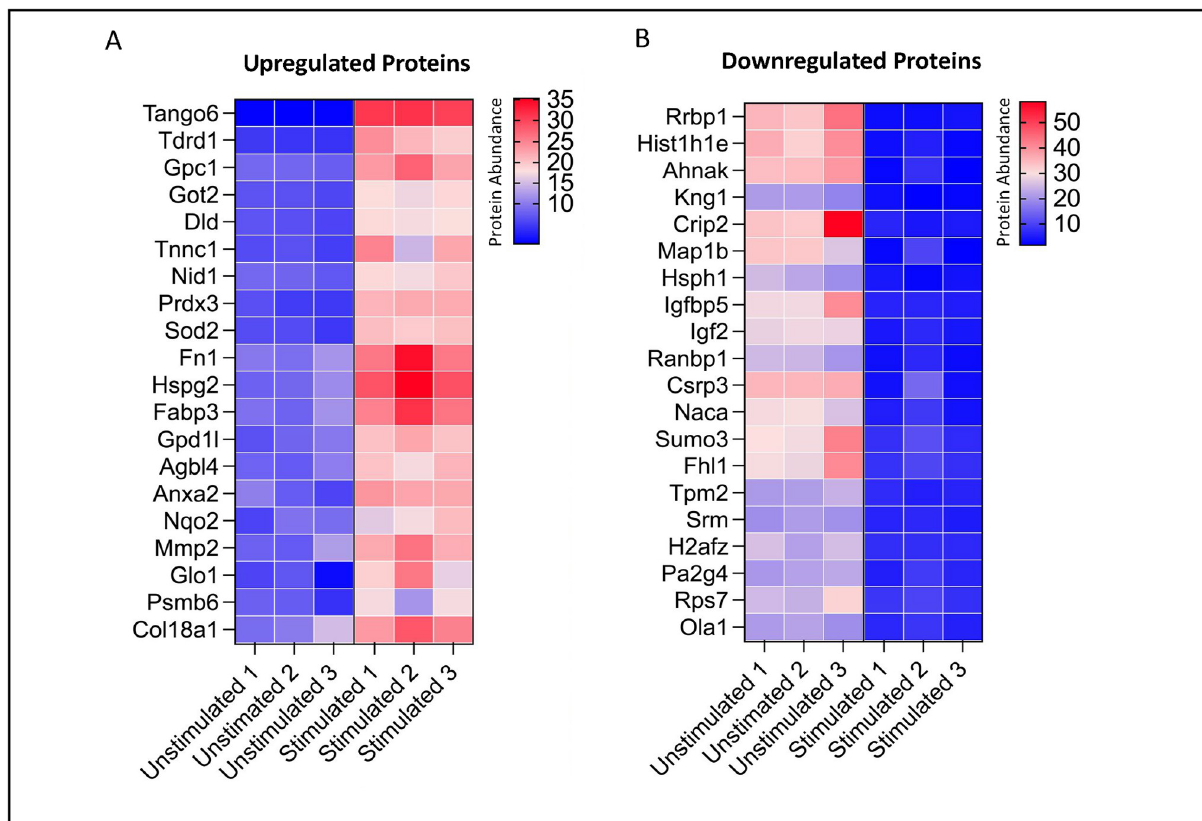
Fig 5. Heat Map of Top 20 upregulated and downregulated proteins in myokine fractions. Proteomic characterization through Tandem Mass Tag Label Mass Spectroscopy revealed marked changes in protein abundance between stimulated and unstimulated myokine fraction. A. Top 20 upregulated proteins in stimulated myokine fraction possessed marked inductions as compared unstimulated control. B. Top 20 downregulated proteins in stimulated myokine fraction also displayed the ability of the stimulated myokine fraction to markedly downregulate protein abundance as compared to unstimulated myokine